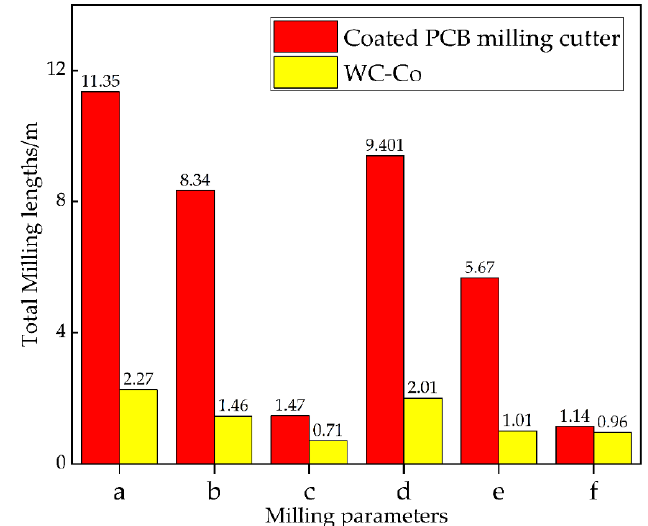
Figure 16. Total milling length for coated and uncoated milling cutters with different milling param- eters: (a) Rev: 42,000 rpm; Vf: 2 mm/s; (b) Rev: 42,000 rpm; Vf: 4 mm/s; (c) Rev: 42,000 rpm; Vf: 8 mm/s; (d) Rev: 38,000 rpm; Vf: 2 mm/s; (e) Rev: 38,000 rpm; Vf: 4 mm/s; (f) Rev: 38,000 rpm; Vf: 8 mm/s.